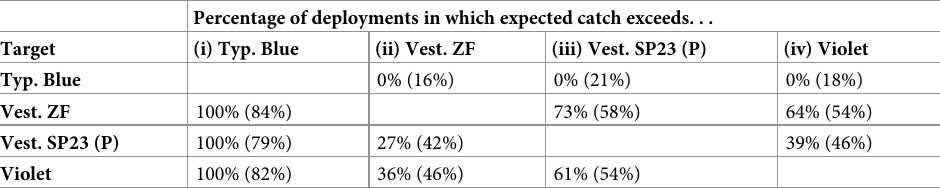
Table shows the percentage of 10,000 simulated catches in which the expected catch ( λ ) of the target in the row heading exceeded that in the column heading for the average catch replicate. Values in brackets indicate the same comparison of catch predictions, but incorporate the additional variability in tsetse catches across replicates estimated by the model.